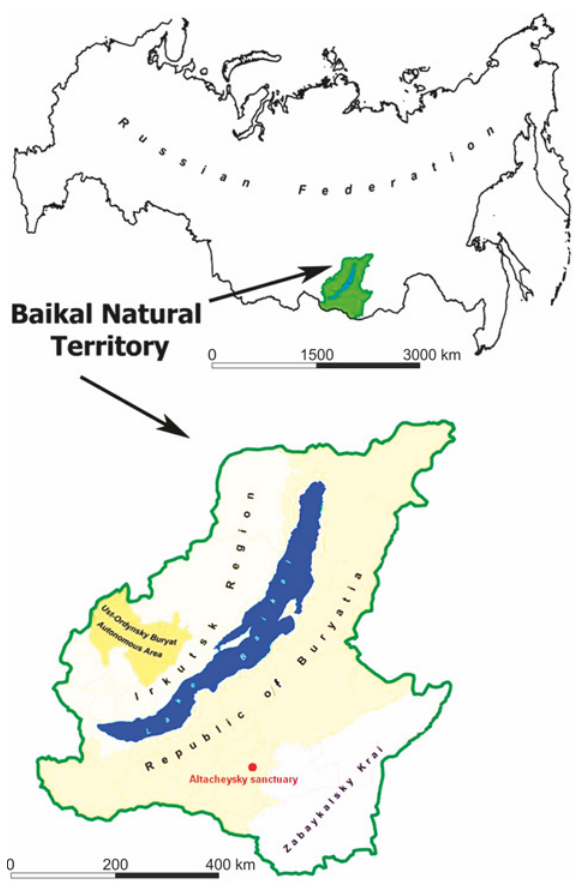
Fig. 1. location of altacheysky